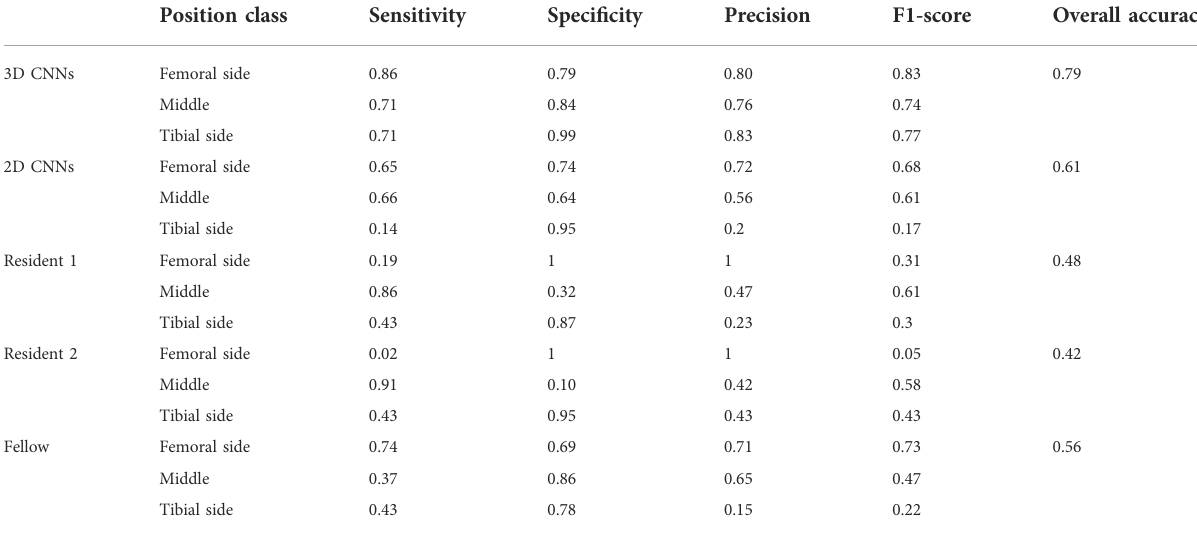
TABLE 5 Sensitivity, speci fi city, precision, F1-score, and overall accuracy for clinical residents, musculoskeletal radiology fellow, 2D CNNs, and 3D CNNs for performance in sides classifying of ACL rupture on the image patches.